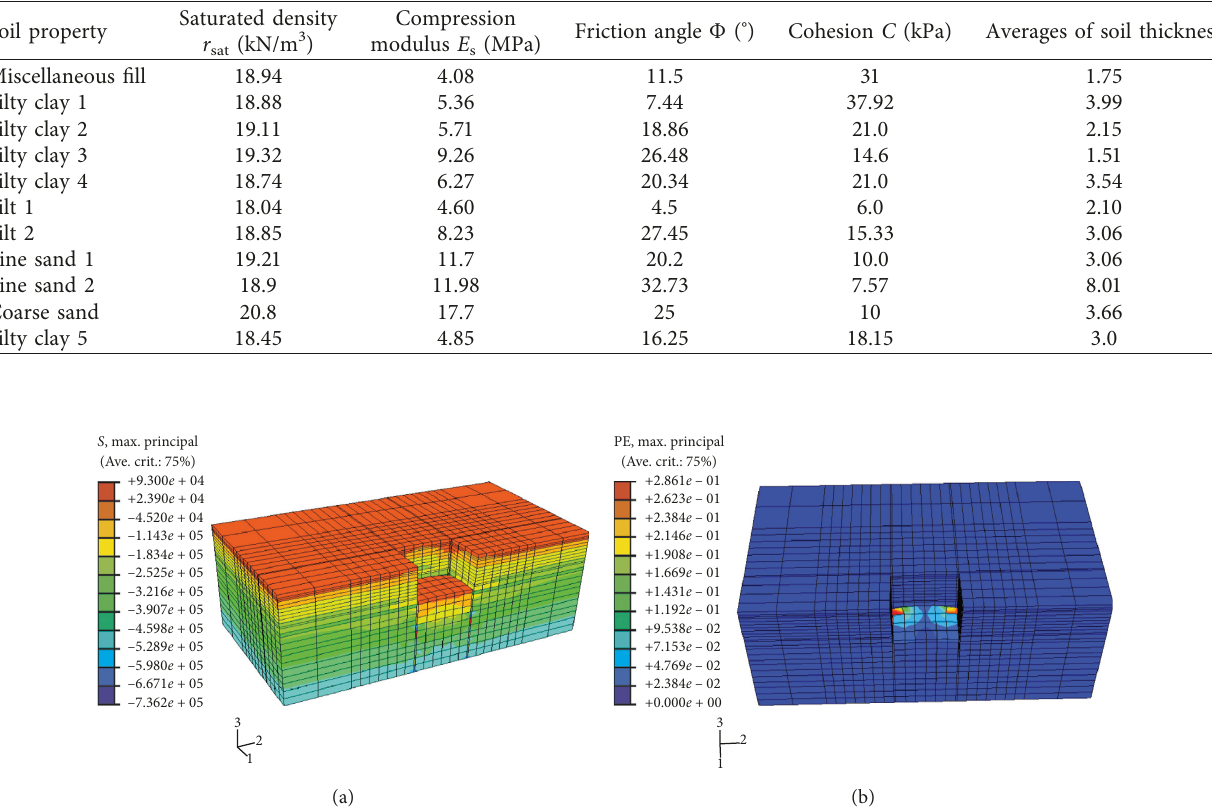
Table 1: Summary of soil parameters.